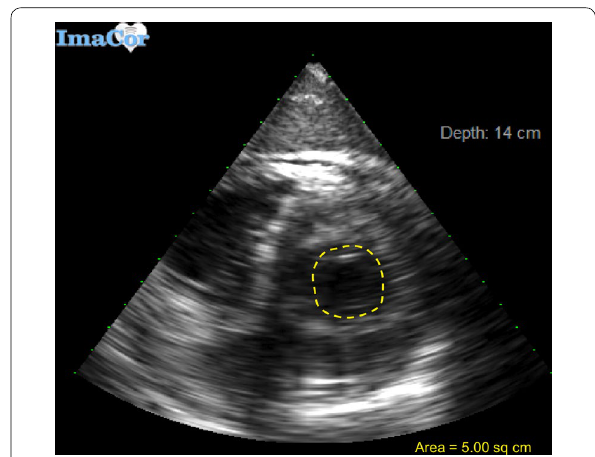
Fig. 4 Transesophageal echocardiographic view demonstrating area tracing of left ventricle in